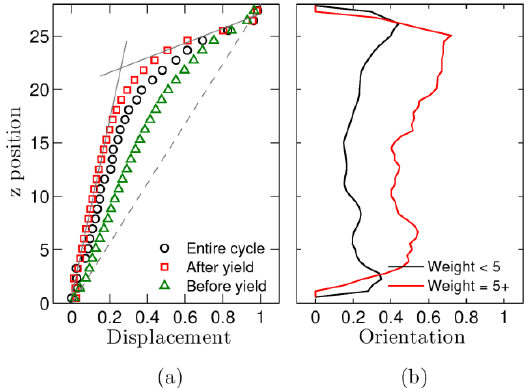
Figure 8. ( a ) Displacement of a layer at a position z from the bottom of the film as a fraction of the displacement of the upper wall. The black circles represent averages over the entire cycle, the red squares those after yield, and the green triangles those before yield. ( b ) Orientation Q xx in the shear direction of the polymer chains that link the aggregates. Data are split in those for links less than weight five (black) and those for weight five and higher (red). See text for discussion.